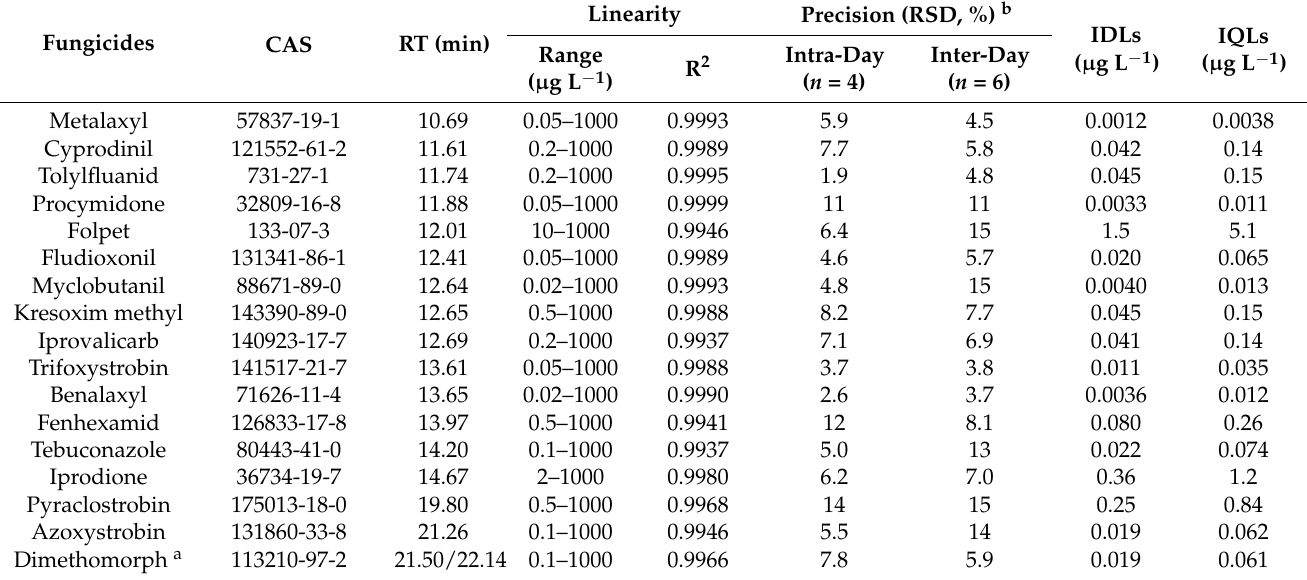
Table 1. Target fungicides, CAS number, retention time, linearity, precision, IDLs and